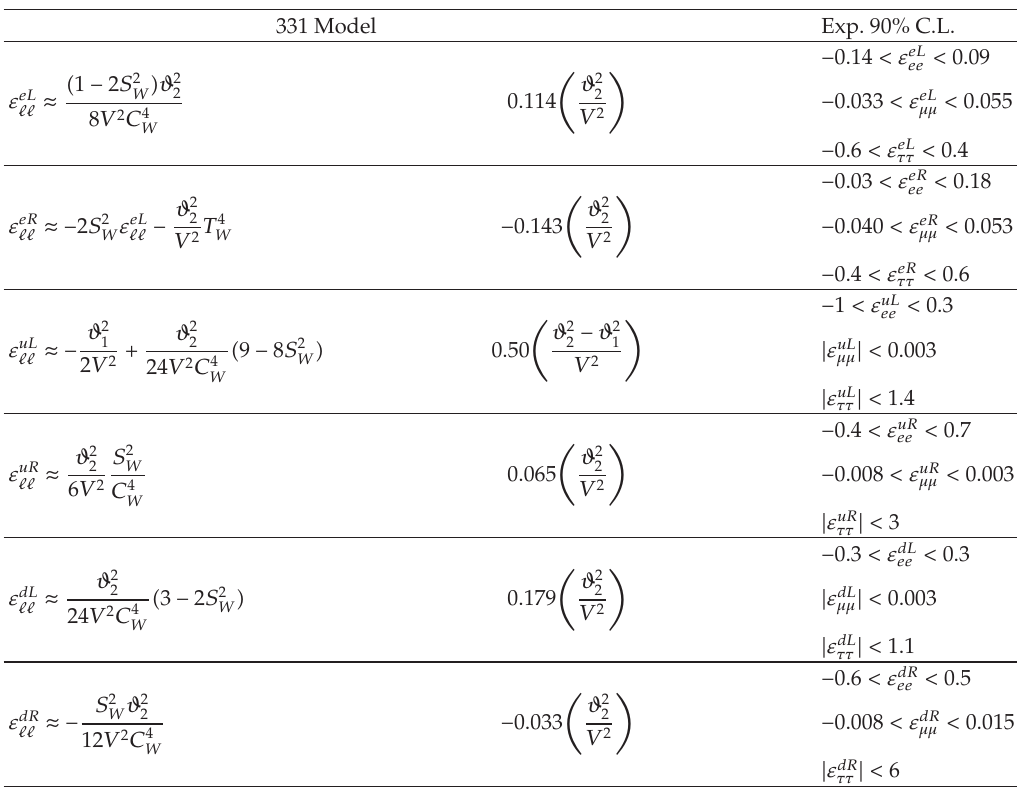
− 0 . 14 < ε eL < 0 . 09 ee